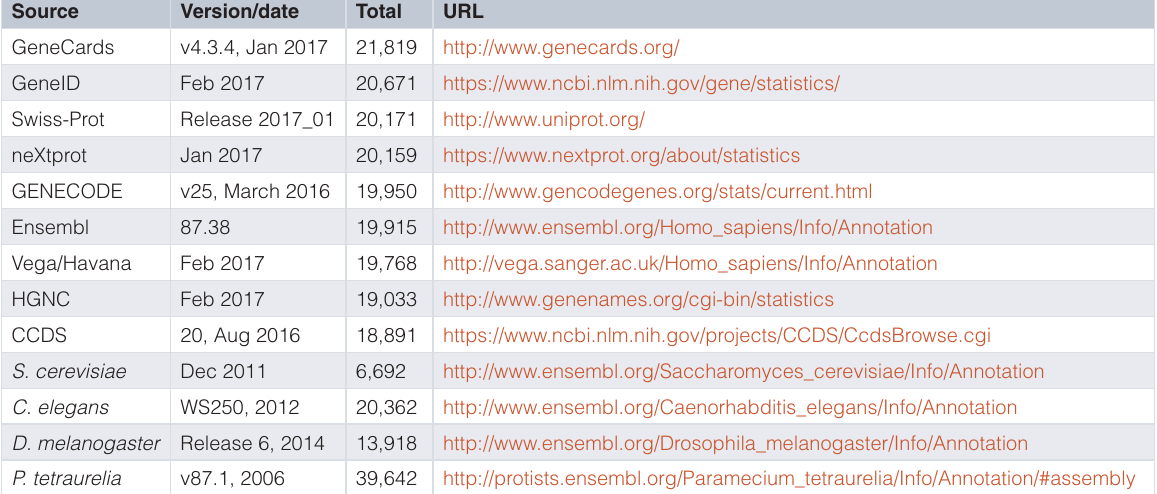
Table 1. Human protein coding gene counts from nine different portals, collected at the beginning of 2017. Ensembl numbers for the yeast, worm, fly and a protozoan are included for comparison (abbreviations are defined in the